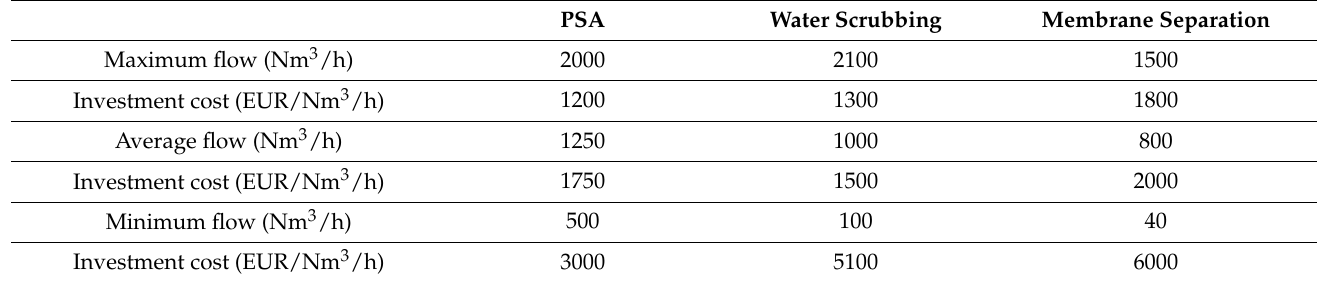
Table 5. Operating ranges and costs of biomethane production on different upgrading [59].